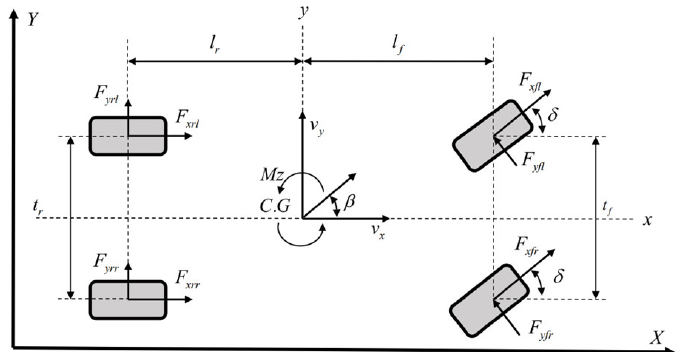
Figure 1. Vehicle planar four-wheel dynamics model. v , and In the above equations, m is the vehicle mass; r , v are the yaw rate, x y longitudinal velocity, and lateral velocity of the vehicle, respectively; is the front wheel I is the rotational inertia of the vehicle around angle; is the vehicle sideslip angle; z the Z -axis; l represents the distance from the vehicle center of mass ( . C G ) to the front and rear axles ( ( ) f front , ( ) r rear ); t represents the wheel track of the front and rear wheels ( , ) f r ; and F and F represent the lateral and longitudinal forces of yij xij the four wheels, respectively, ( ij fl (left-front wheel), fr (right-front wheel), rl (left- rear wheel), rr (right-rear wheel)).